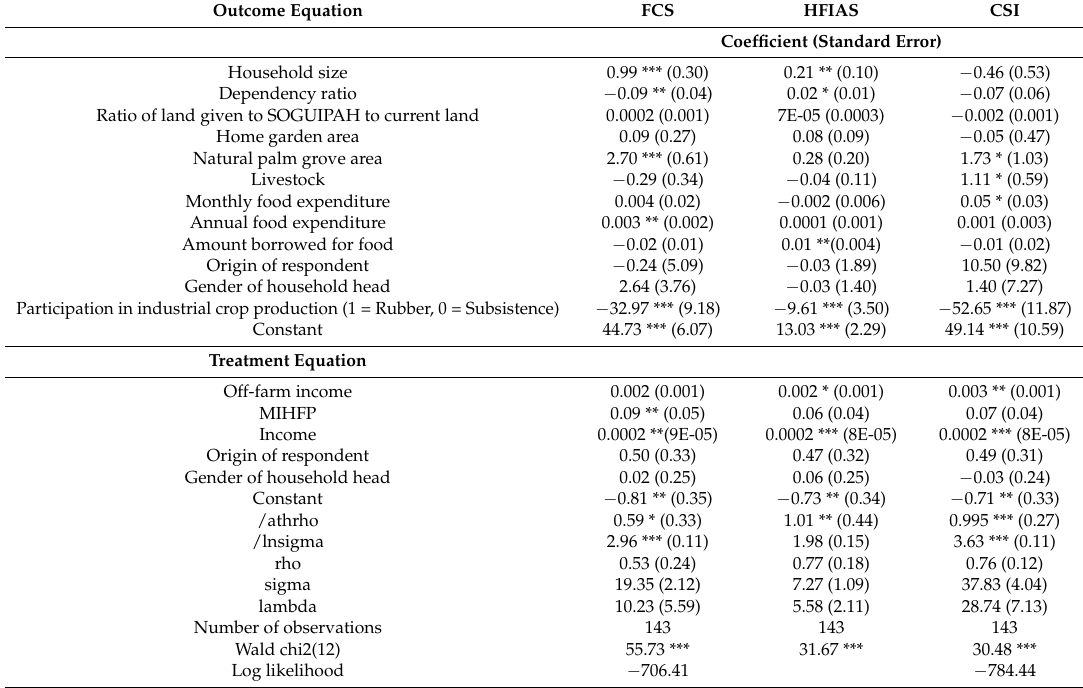
Table 5. Linear Regression with Endogenous Treatment Effects for participation in rubber production.